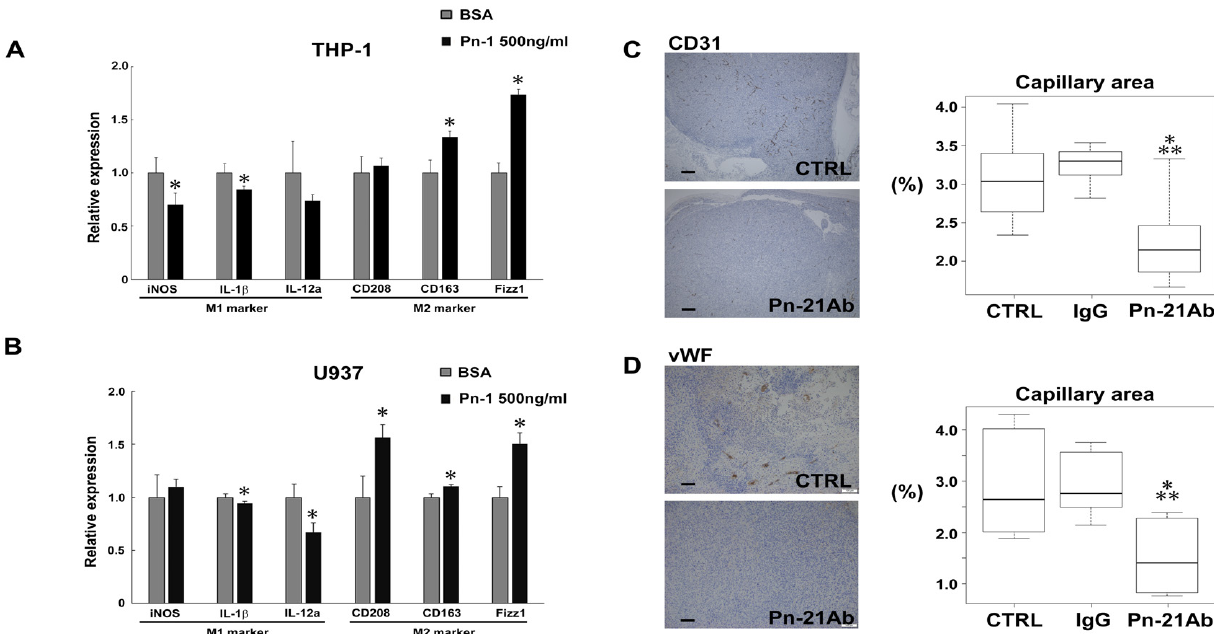
Figure 5. Pn with exon 21 reduces M1 macrophage markers but enhances M2 macrophage markers. U937 M0 macrophages were treated with recombinant full-length Pn protein, Pn-1. ( A , B ) RT-qPCR analyses showing upregulation of M2 TAM markers induced by recombinant Pn-1 in THP-1 ( A ) or U937 ( B ) macrophages. PMA-treated macrophages were stimulated with recombinant Pn (500 ng/mL) in RPMI media supplemented with 0.1% BSA for 24 h. RT-qPCR analysis indicated downregulation of M1 markers (iNOS, IL-1 β and IL-12a) and up-regulation of M2 markers (CD206, CD163 and Fizz1). Data are shown in mean ± SD, n = 4 per group, * p < 0.05 vs. BSA. Student’s t -test. ( C , D ) Immunohistochemical staining of CD31 ( C ) or vWF ( D ), an endothelial cell marker. CD31- or vWF-positive area in tumors was quantitated in at least 4 view fields per tumor by using Image J program. ( n = 6–7). *, ** p < 0.05 vs. CTRL, IgG, respectively. Box plot showing mean % of capillary area in tumors. Scale bars represent 100 μ m. p values were calculated by using the one-way ANOVA test and Tukey–Kramer’s post hoc test.